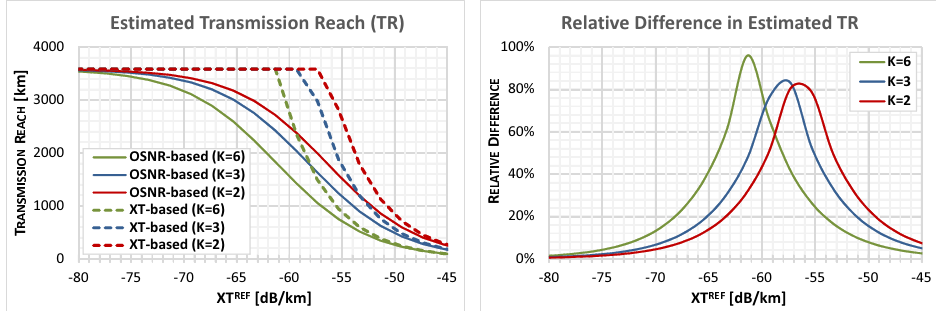
Figure 1. Comparison of estimated transmission reaches in a function of crosstalk level for OSNR- based and XT-based QoT models assuming QPSK modulation